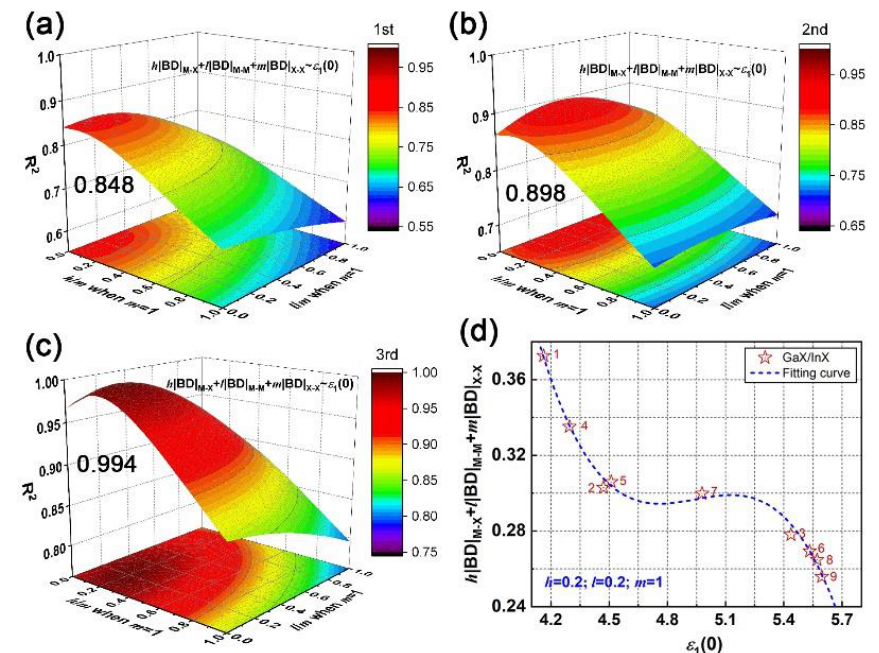
Figure 9. Fitting h | BD | M–X + l | BD | M–M + m | BD | X–X vs. ε 1 (0) of N ◦ 1–9 GaX / InX by adjusting h / m and l / m ratios: the coe ffi cient of determination (R 2 ) as equation order goes from ( a ) first, ( b ), second, and ( c ) third. ( d ) The cubic fitting curve at the maximum R 2 when h / m and l / m ratios are both 0.2.